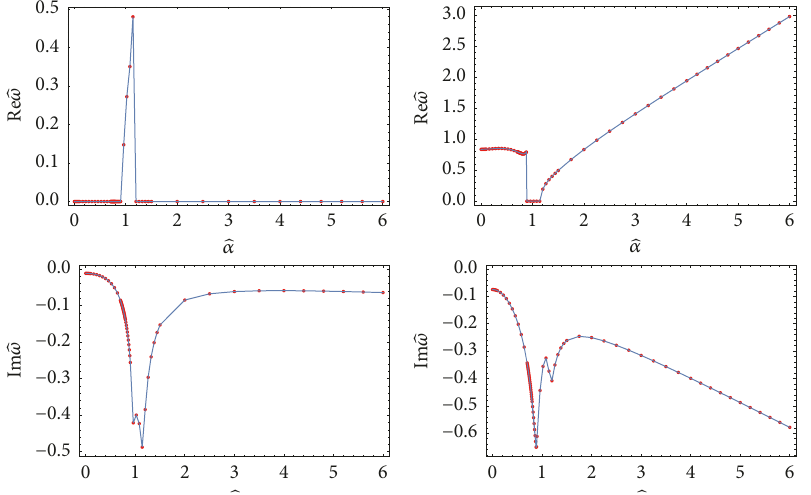
Figure 10: Evolution of the dominant QNMs with ̂𝛼 for 𝛾 1 = −1 . The left column is the QNMs for the original theory, and the right one is that for its dual